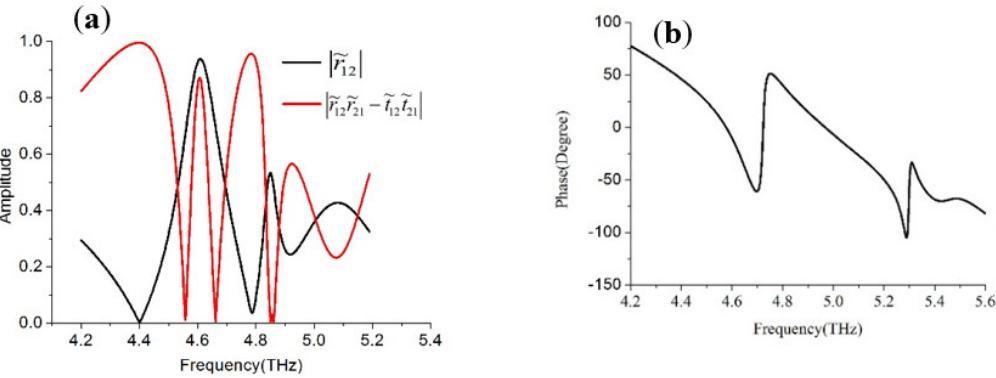
Figure 8. The calculated ( a ) amplitude and ( b ) phase of the reflection and transmission coefficients using the interference theory.